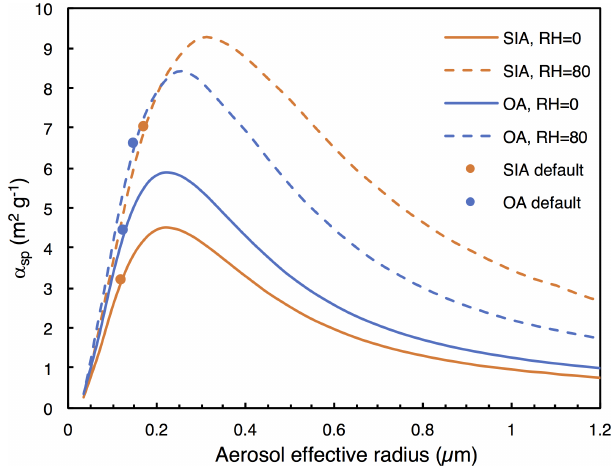
Figure 5. Mass scattering efficiency ( α sp ) at 550nm as a function of aerosol wet effective radius for organic aerosol and secondary inorganic aerosol. Solid lines show α sp for dry aerosol (RH = 0%); dashed lines show α sp for aqueous aerosols (RH = 80%). Points represent the default size in